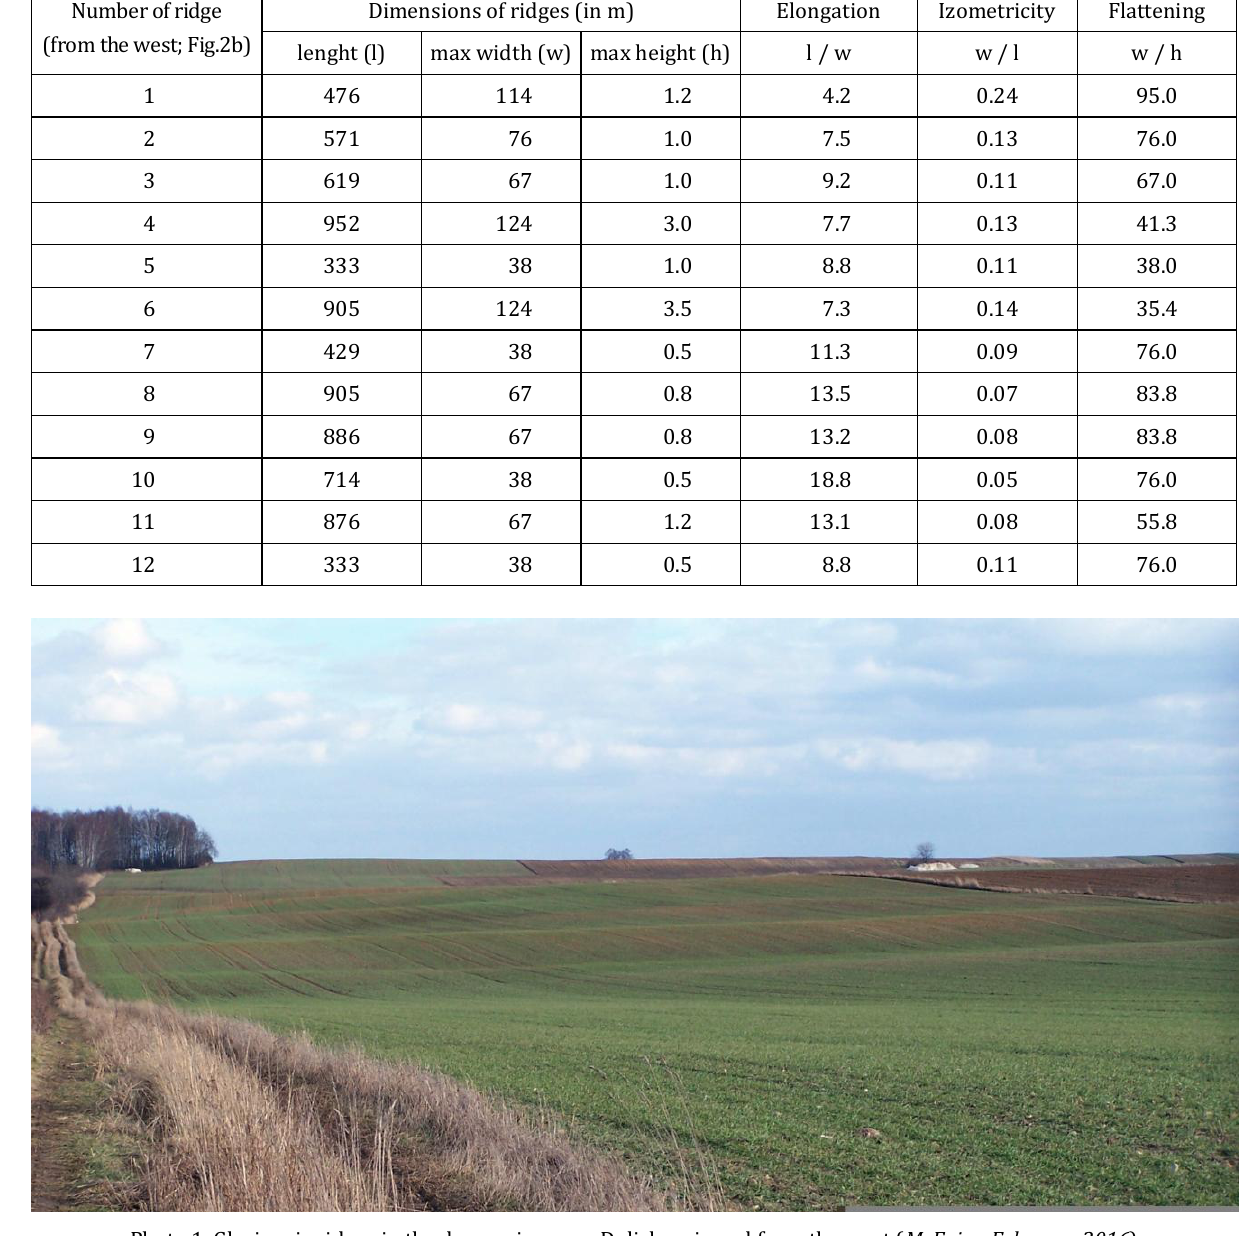
Photo 1. Glacigenic ridges in the depression near Dolisko, viewed from the west ( M. Fajer, February 2016